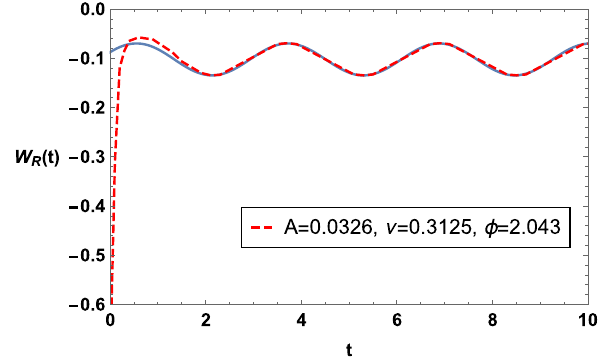
Fig. 4 Evolution of the expectation value of Wilson loop W R ( t ) as a function of boundary time t . We fixed the interquark distance l = 1, final value of the chemical potential μ = 0 . 0220, final value of the temperature T = 0 . 2200 and the transition time k = 0 . 3. The dashed red curve shows the evolution of Wilson loop and the blue sine curve is the fitted function, i.e. W f ( t ) = A cos ( 2 πν t + φ) where, A is the amplitude of the oscillation, ν is the oscillation frequency and φ is a phase value. Reprinted from